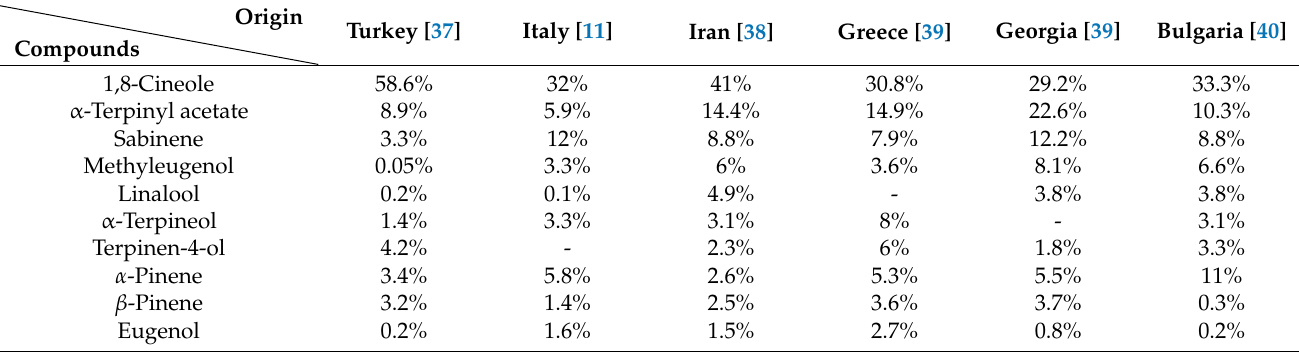
Table 1. Composition of the EO of laurel leaves from different